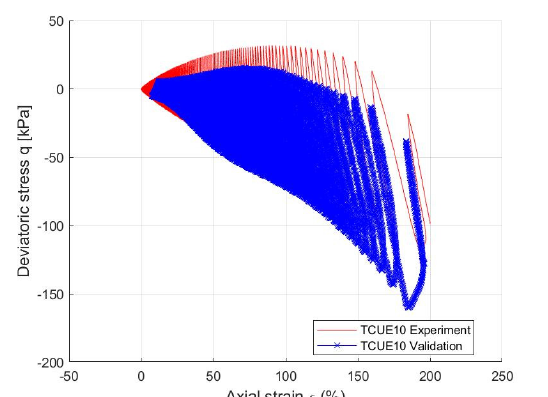
Fig. 8 Effective stress paths in undrained cyclic triaxial tests with relatively small strain cycles ( I D0 = 0.56 and p 0 =200 kPa).